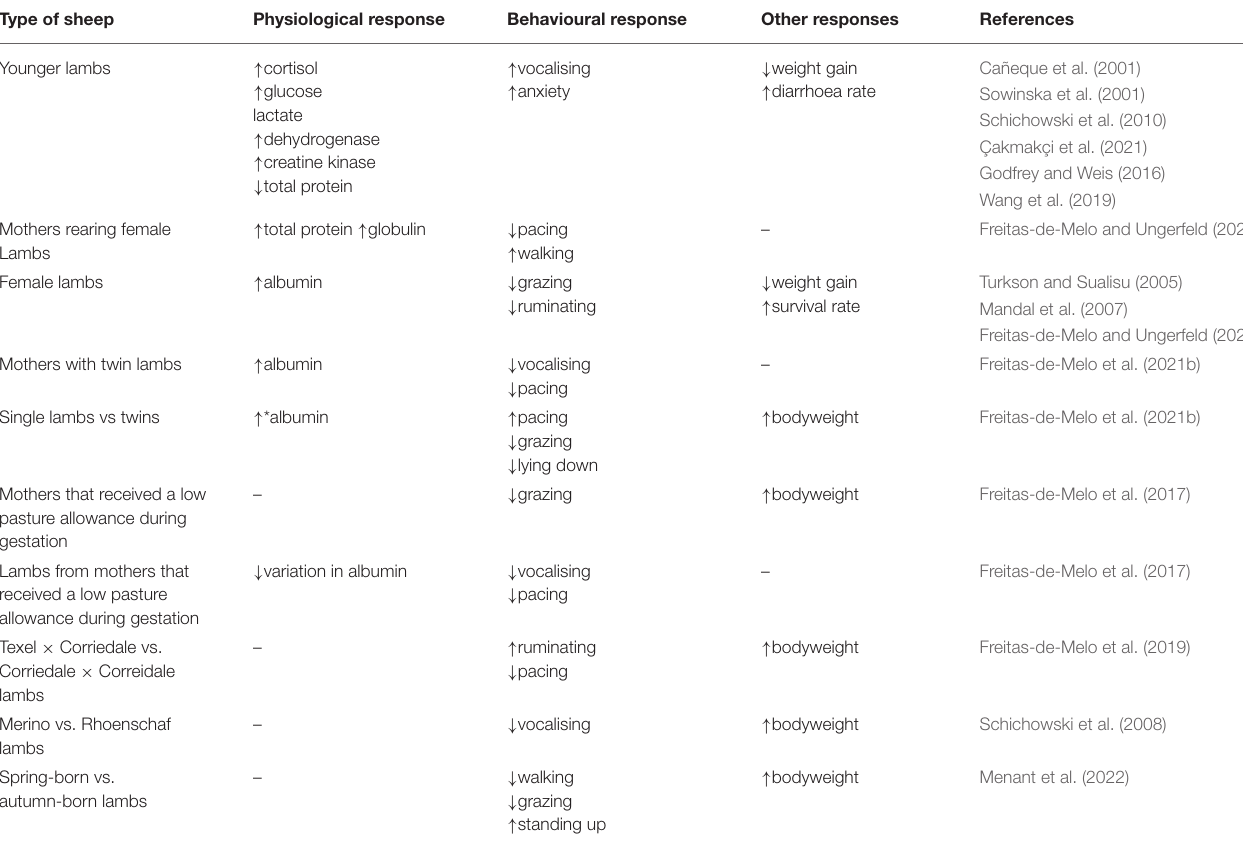
TABLE 2 | Factors involved in the physiological, behavioural and immunological responses at artificial weaning in ewes and